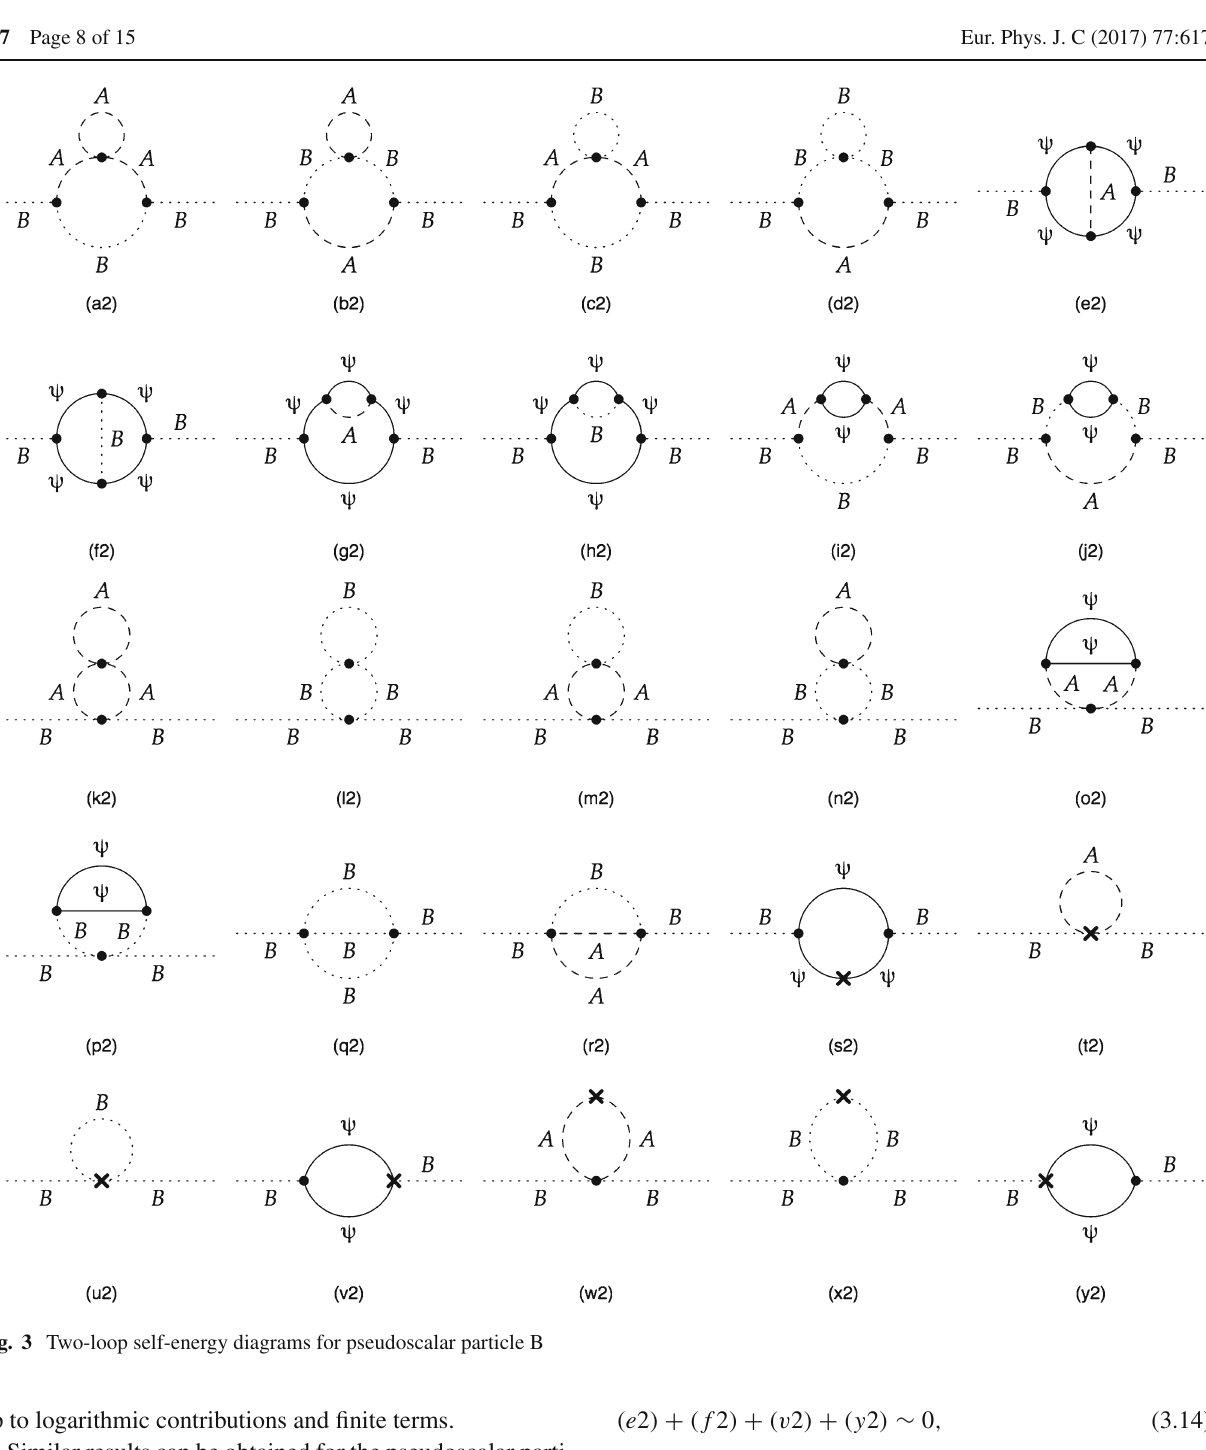
up to logarithmic contributions and finite